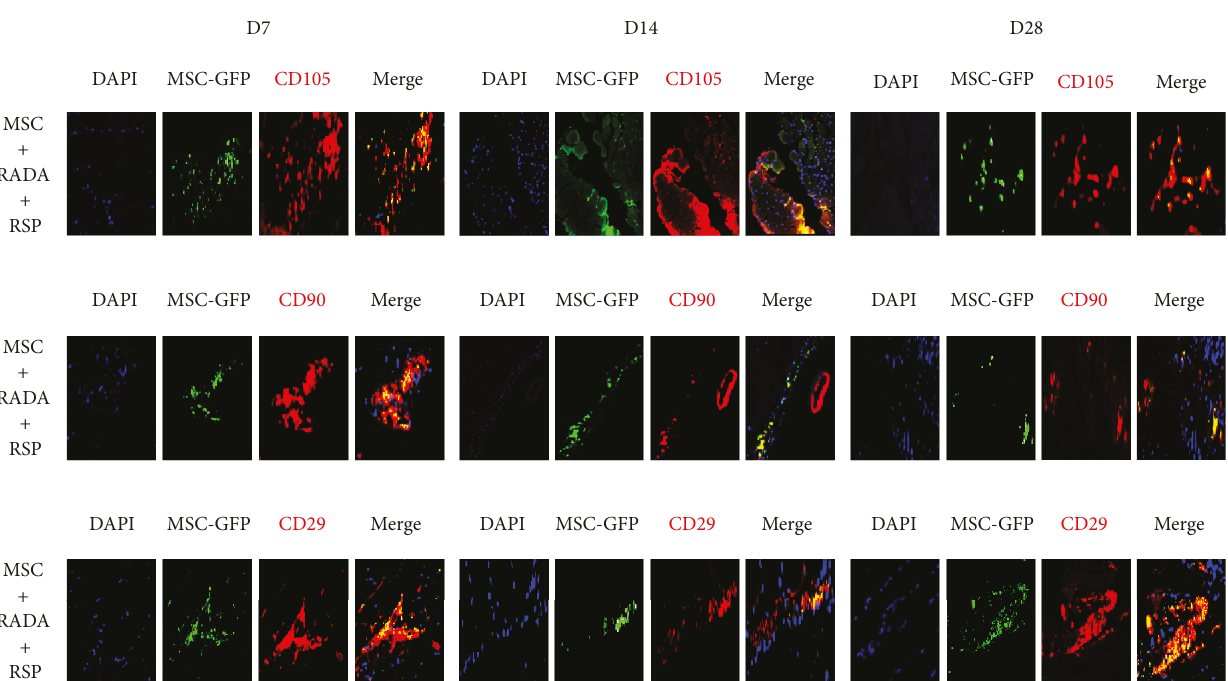
Figure 6: Fluorescent immunohistochemical staining for stem cell markers CD105, CD90, and CD29 from ischemic hindlimbs injected with a combination of MSC, RADA, and RSP (10x magni fi cation). RSP is proposed as being stronger in recruiting endogenous MSCs and therefore the combination of MSCs with RADA and RSP showed the presence of both injected MSCs (yellow stain) and endogenously recruited MSCs (red stain) in the merged images for the di ff erent markers at di ff erent time